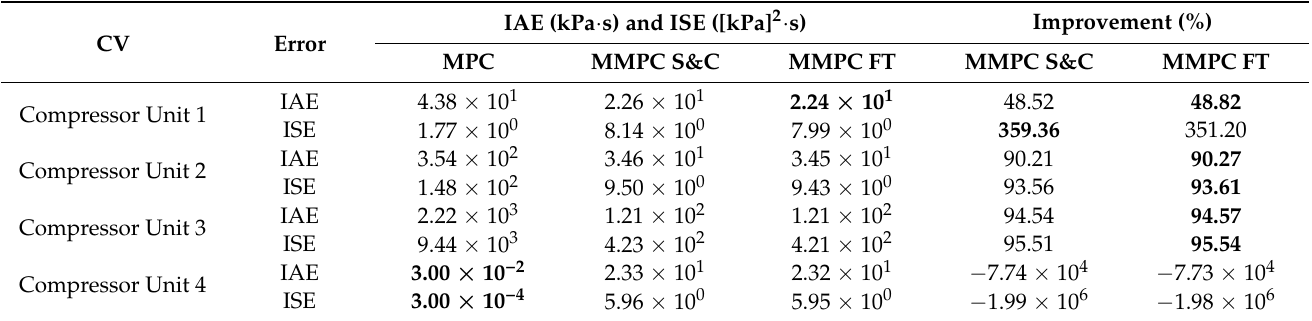
Table 9. Comparison of IAE and ISE on the compressor unit with changes on compressor unit 3 (MIMO Model 1).